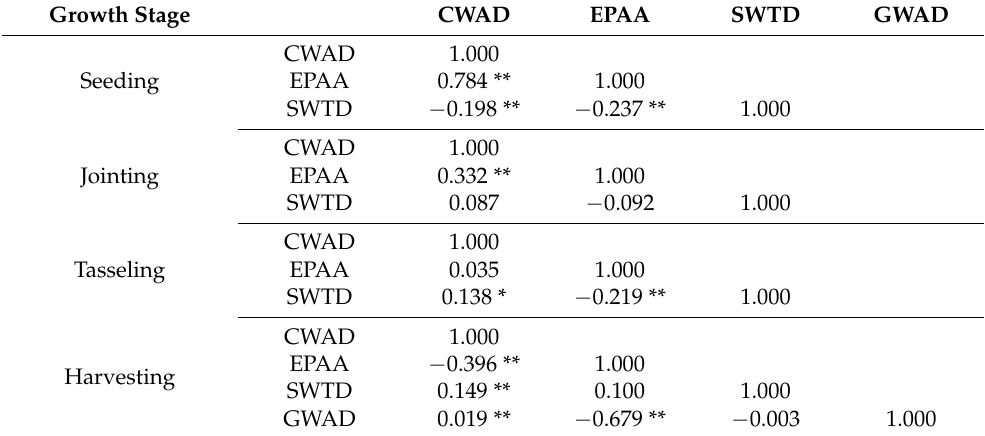
Table 3. Correlation between crop production and water